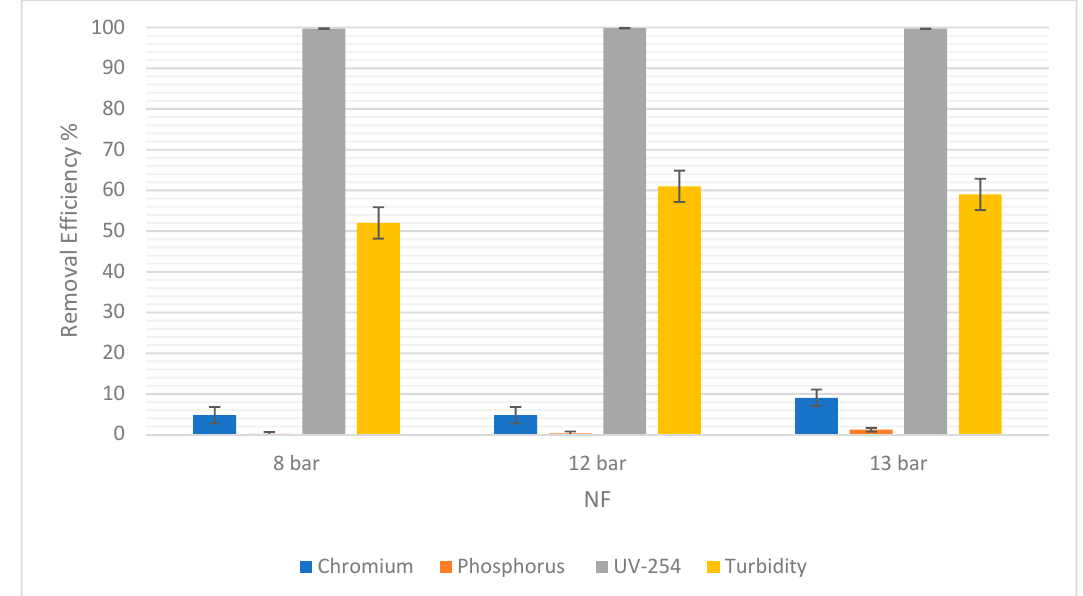
Figure 7. The removal efficiency of pollutants for NF at 8, 12, and 13 bars.